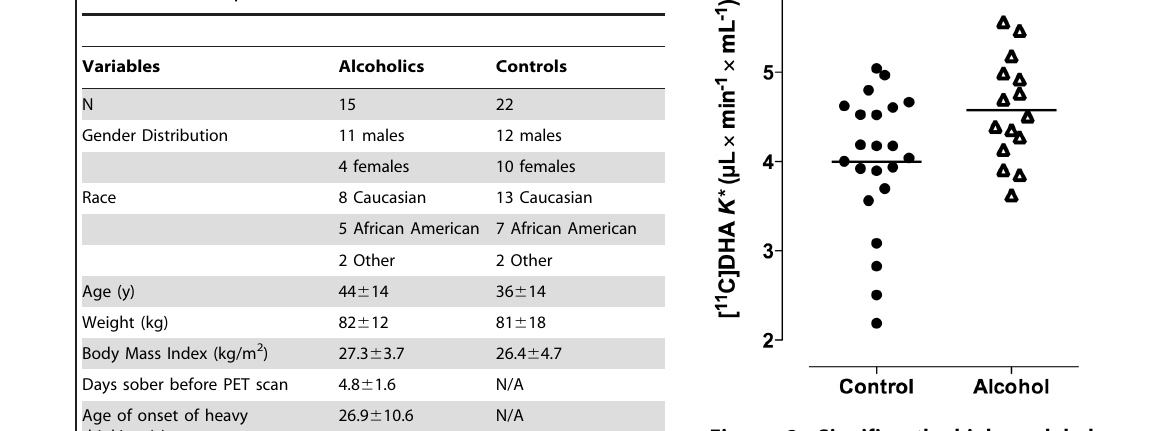
Figure 2. Significantly higher global gray matter K* for [1- 11 C]DHA in alcoholics vs. controls. (t-test p=0.025; rmANOVA main effect of group,